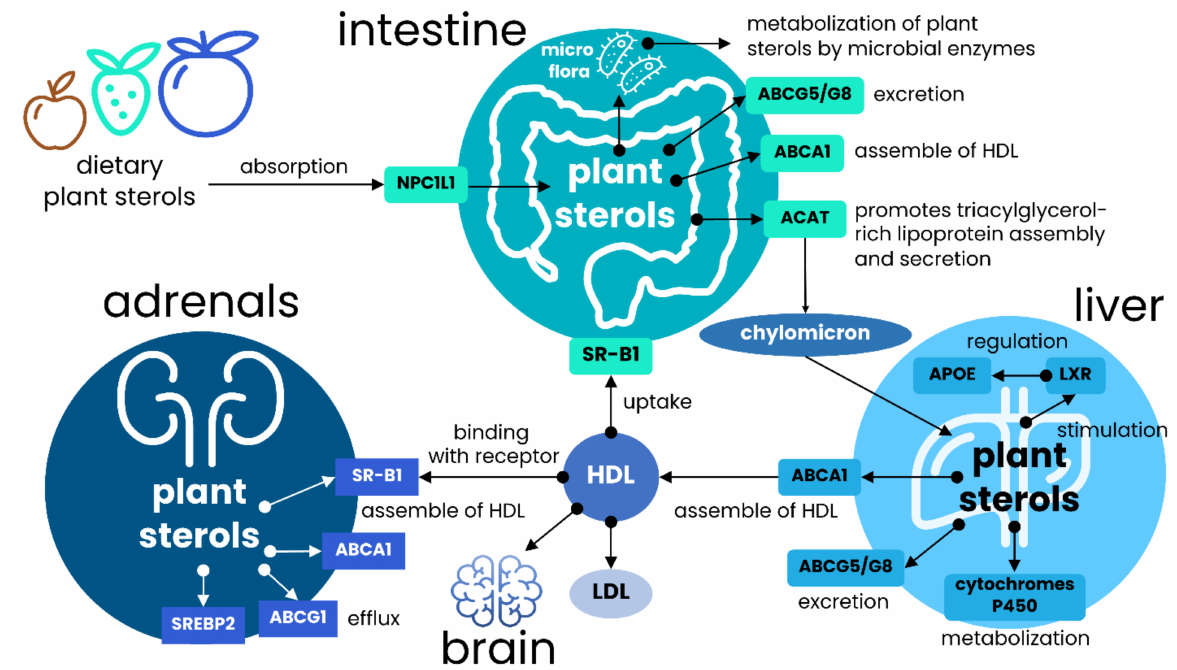
Figure 1. General scheme of the major routes of plant sterols in human. Plant sterols and dietary cholesterol are mainly absorbed in intestine, and Niemann-Pick C1-like 1 (NPC1L1) transporter plays a vital role in the regulation of initial absorption. After absorption, sterols are esterified in support with ACAT and transported to the liver following the incorporation into chylomicrons. In contrast, unesterified sterols are pumped out by ABCG5/ABCG8 transporters, which are the major cholesterol and plant sterols transporters. The plasma efflux of both plant sterols and cholesterol is regulated by ABCA1, which is involved in the assembling of HDL-like particles with the assimilated sterols. This transporter is also critically important in plant sterols and cholesterol efflux after delivering chylomicrons from enterocytes to liver cells. Plant sterols are capable of stimulating LXR receptors regulating APOE expression, which is essential for HDL and LDL assembly and uptake; and can be partially catalyzed by microsomal cytochromes. Binding with LXR receptors upregulates ABCG5/G8 transporters, and thus enhances cholesterol and plants sterols absorption. The exported HDL-like particles with the incorporated plant sterols are trapped by SR-IB receptors expressed on the liver and adrenal glands cell surface. This receptor plays a pivotal role in the uptake of cholesterol through HDL and, most importantly, for brain lipids metabolism, where HDL is the primary source of lipids and cholesterol